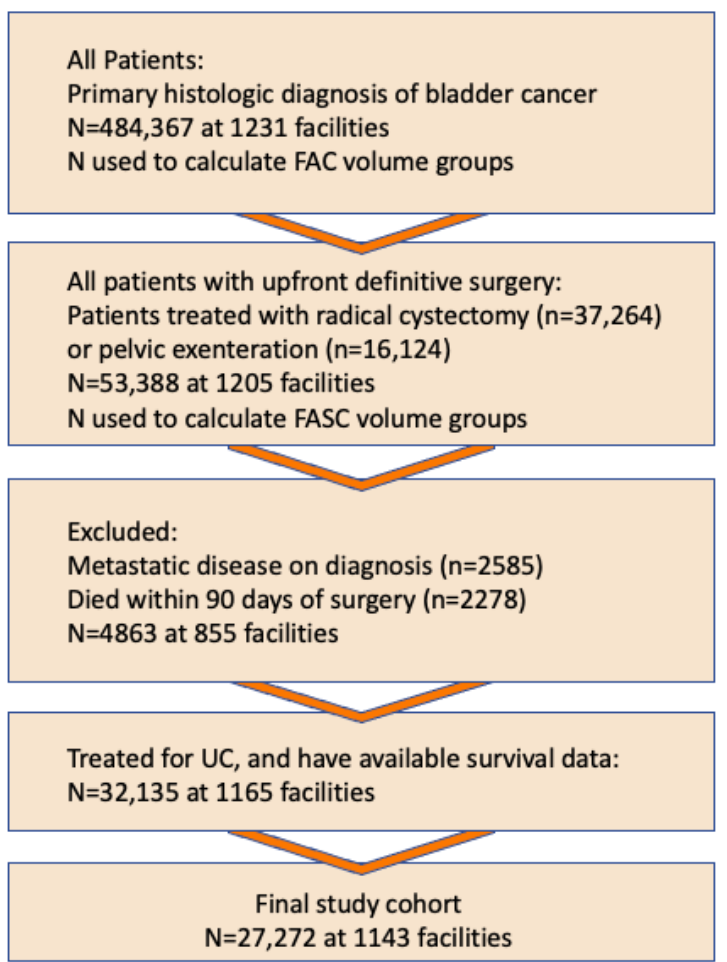
Figure 1. Cohort selection process. As the focus of this analysis and the hypothesis tested here is the impact of caseload on the oncologic outcome of bladder cancer surgery, the 90-day mortality,